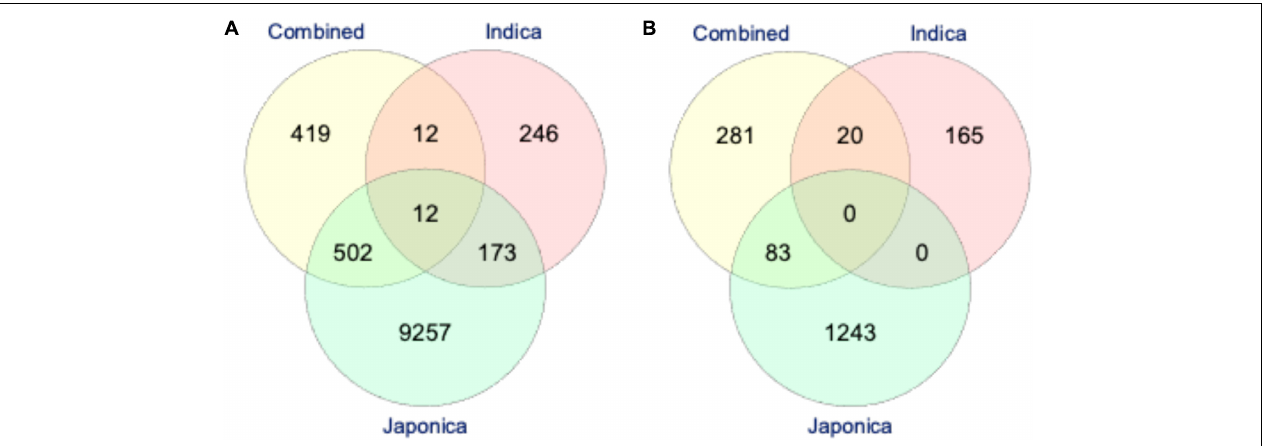
FIGURE 7 | The Venn-diagram showing the number of putative candidate genes identified by highly significant genome-wide association studies (GWAS) SNPs associated with PL (A) and NSP (B) under HNT stress across the rice populations; the Combined ( yellow ), Indica ( pink ), and Japonica ( green ) populations. The reference rice genome was scanned for the identification of putative candidate genes based on the extent of linkage disequilibrium (LD) of each highly significant GWAS SNP in all the rice populations (described in “Materials and